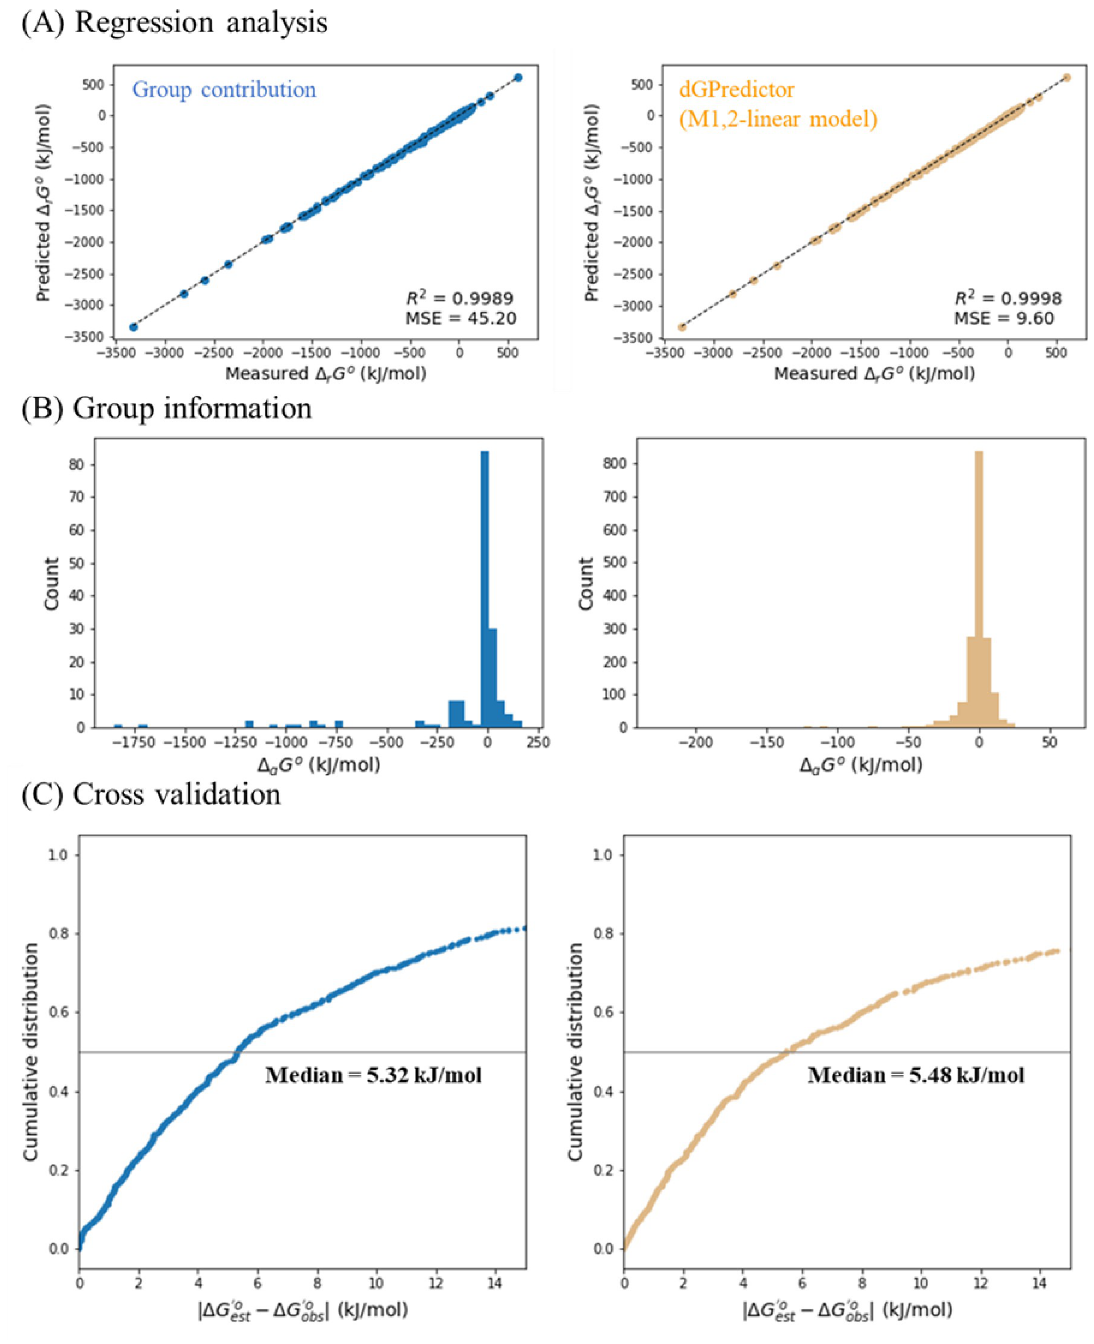
Fig 2. Comparison between group contribution method by Noor et al. [14] and dGPredictor (best model: M1,2-linear). (A) Comparison of regression analysis for the best dGPredictor model (M1,2-linear model) and previous group contribution method. It shows the improvement in the mean squared error (MSE improved from 45.20 (kJ/mol) 2 to 9.60 (kJ/mol) 2 and nearly identical R- squared values. (B) Histogram denoting the estimated contribution of groups. dGpredictor group contribution estimates do not predict unrealistically high values, unlike group contribution. (C) leave-one-out cross-validation results, which indicates very close performance with the previous method with an improved MSE value.